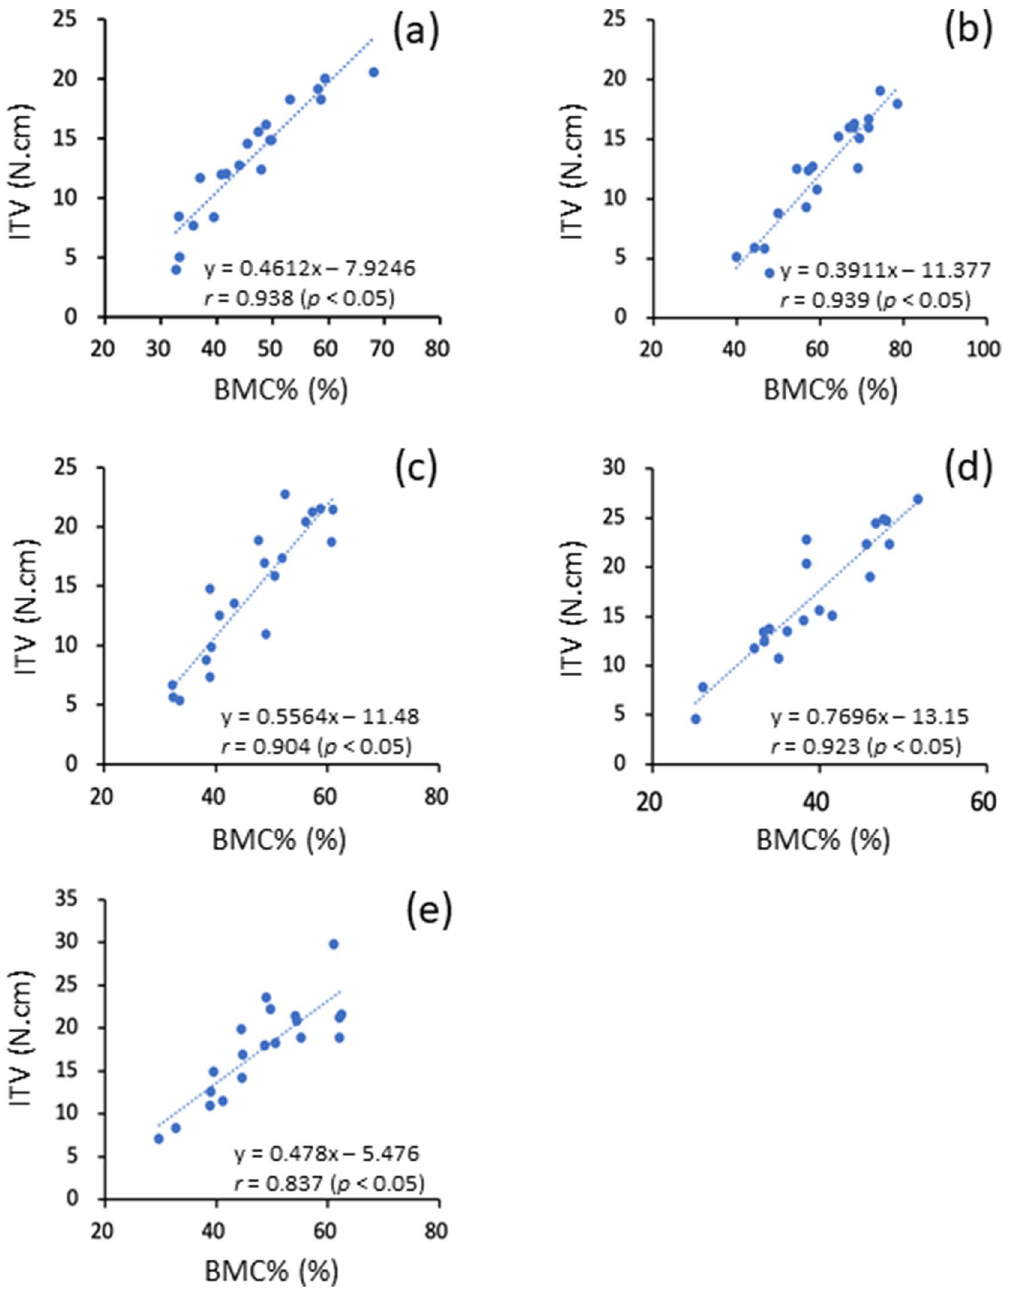
Figure 3. Relationships between ITV and BMC% in the ( a ) 1.4 × 8 mm 2 miniscrew group, ( b ) 1.5 × 6 mm 2 miniscrew group, ( c ) 1.5 × 8 mm 2 miniscrew group, ( d ) 1.5 × 10 mm 2 miniscrew group, ( e ) and 1.6 × 8 mm 2 miniscrew